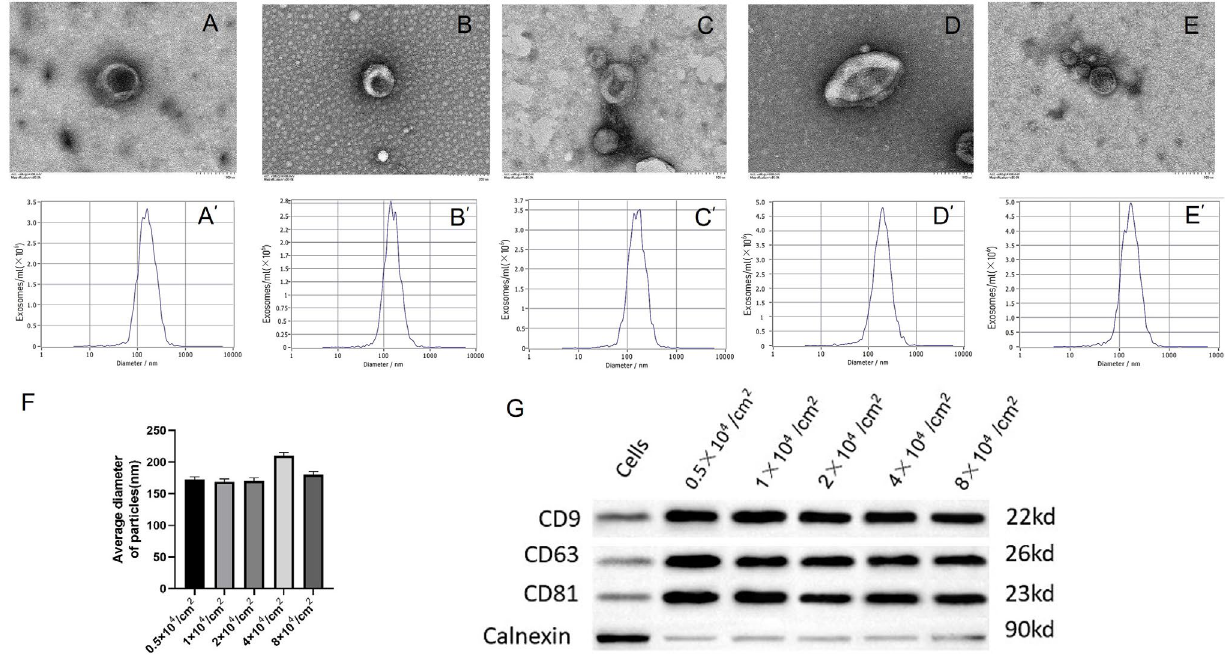
Figure 3. Identification of exosome characteristics from different hPDLSC culture density groups for 3 days of culture (0.5 × 10 4 , 1 × 10 4 , 2 × 10 4 , 4 × 10 4 , and 8 × 10 4 /cm 2 ). Representative transmission electron microscopy images of isolated exosomes from different hPDLSC initial cell culture densities ( A – E ). Size distribution of exosomes obtained via nanoparticle tracking analysis ( A′ – E′ ). Average particle diameter of isolated exosomes from different hPDLSC initial culture densities ( F ). Western blotting analysis of several representative proteins of isolated exosomes derived from cells (hPDLSCs) plated at 0.5 × 10 4 , 1 × 10 4 , 2 × 10 4 , 4 × 10 4 , and 8 × 10 4 /cm 2 ( G ).